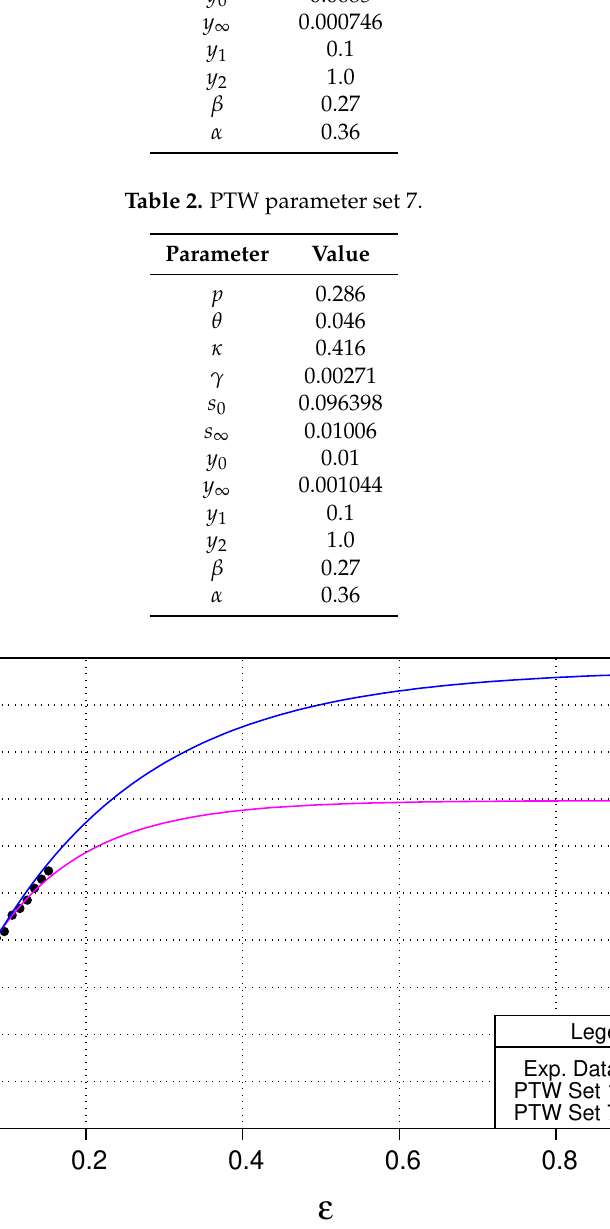
Figure 1. Approximation of Figure 3 in [9] ( T = 333 K, ρ = 6.6877 g/cm 3 , ˙ (cid:101) = 4.2 × 10 3